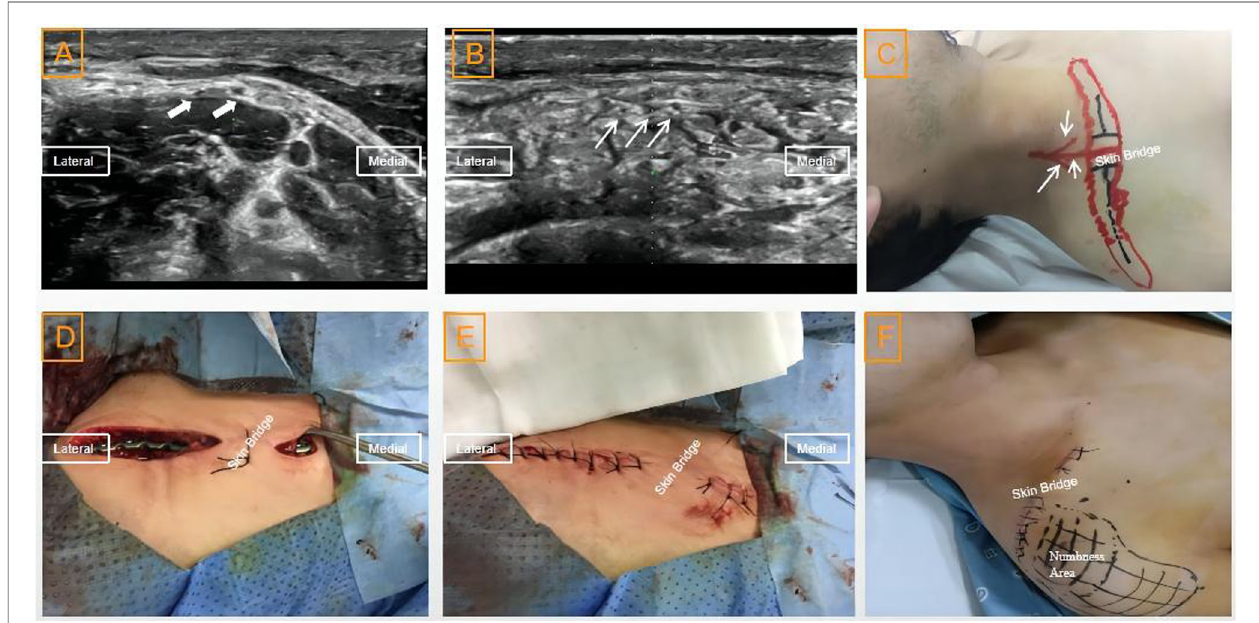
FIGURE 3 | Ultrasound images, projection on body surface of the supraclavicular nerve, skin fl ap (bridge) and numbness area after the operation in case 3: ( A ) ultrasound images of the branches of the supraclavicular nerve at its origin (indicated with a thick white arrow); ( B ) ultrasound images of the branches of the supraclavicular nerve (indicated with a thin white arrow) anterior to the clavicle (indicated with a white cross arrow); ( C ) projection of the branches of the supraclavicular nerve on the body surface and skin fl ap (bridge) before the operation; ( D ) skin fl ap during the operation; ( E ) skin fl ap after the operation; and ( F ) numbness area after the